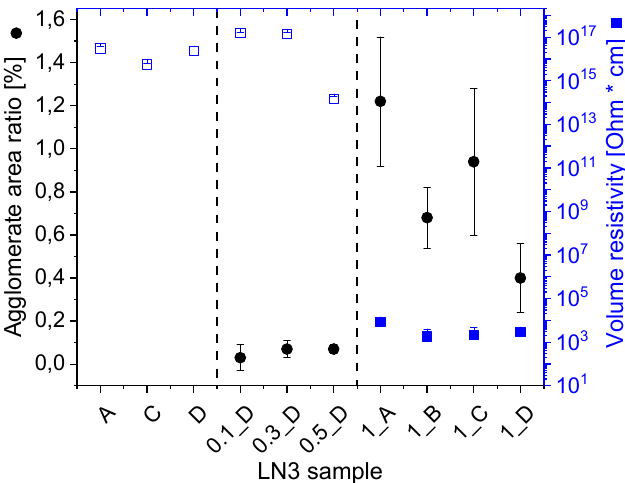
Figure 10. Agglomerate area ratio and volume resistivity of LN3 and LN3/MWCNT composites for processing conditions A (180 °C, 100 rpm), B (180 °C, 200 rpm), C (200 °C, 100 rpm) and D (200 °C, processing conditions A (180 ◦ C, 100 rpm), B (180 ◦ C, 200 rpm), C (200 ◦ C, 100 rpm) and D (200 ◦ C, 200 rpm).